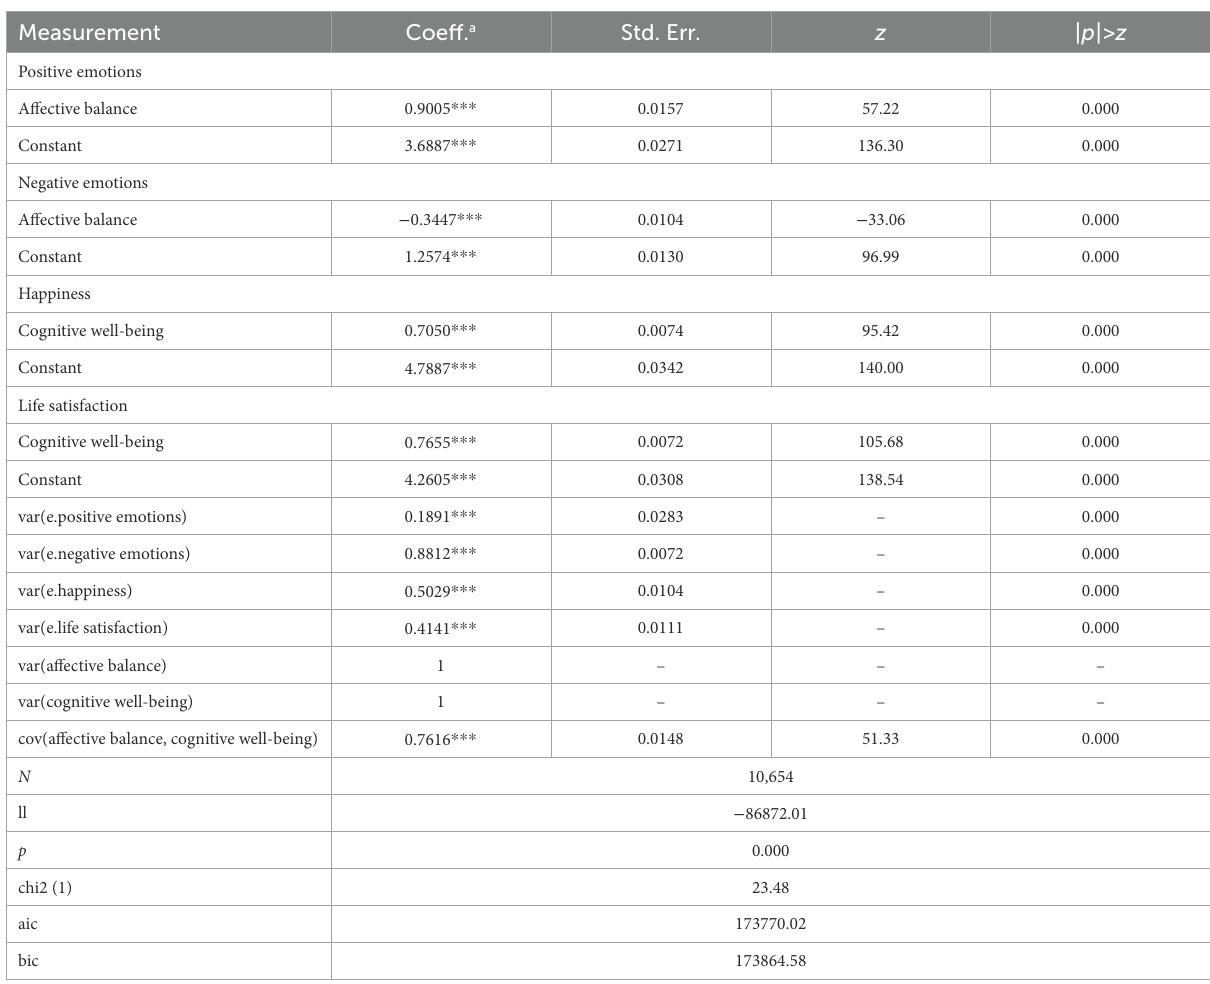
TABLE 1 CFA estimates, subjective well-being